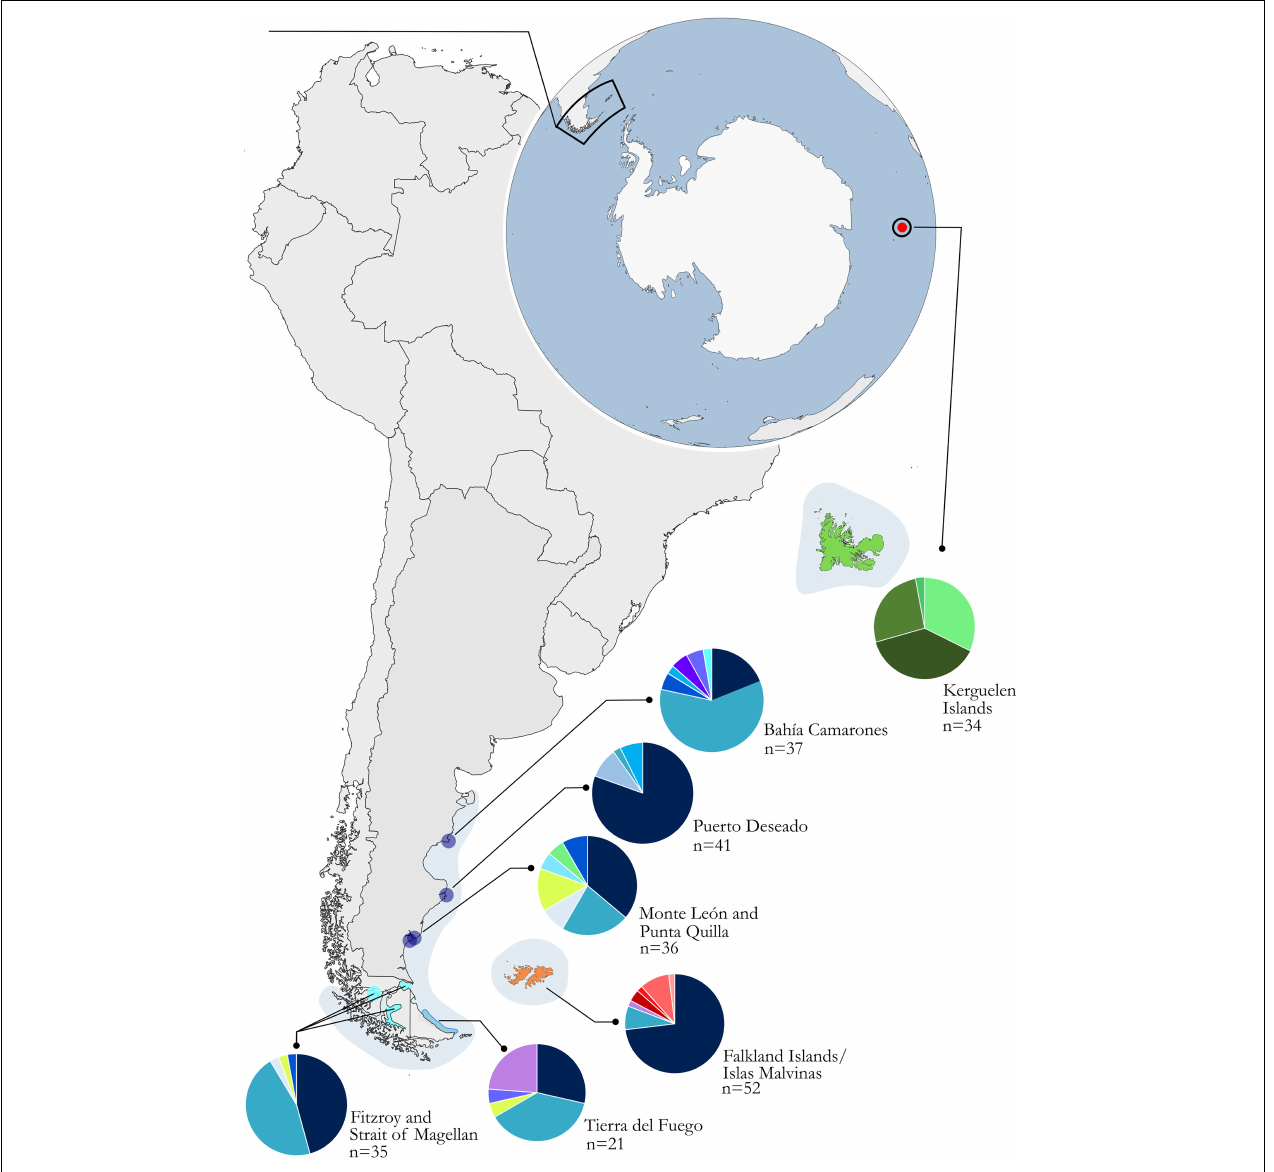
FIGURE 1 | Geographic origin of samples within the distribution of Cephalorhynchus commersonii . Pie charts of each locality detail the respective haplotype frequencies. Haplotype frequencies are available in Table 1 . The localities of Bahía Camarones, Puerto Deseado, and Punta Quilla with Monte León are included in the greater group of Northern South America (dark blue); Tierra del Fuego (blue), and Fitzroy and Strait of Magellan (light blue) in the group Southern South America; Falkland Islands/Islas Malvinas (orange) and Kerguelen Islands (green). Map adapted from FreeVectorMaps.com